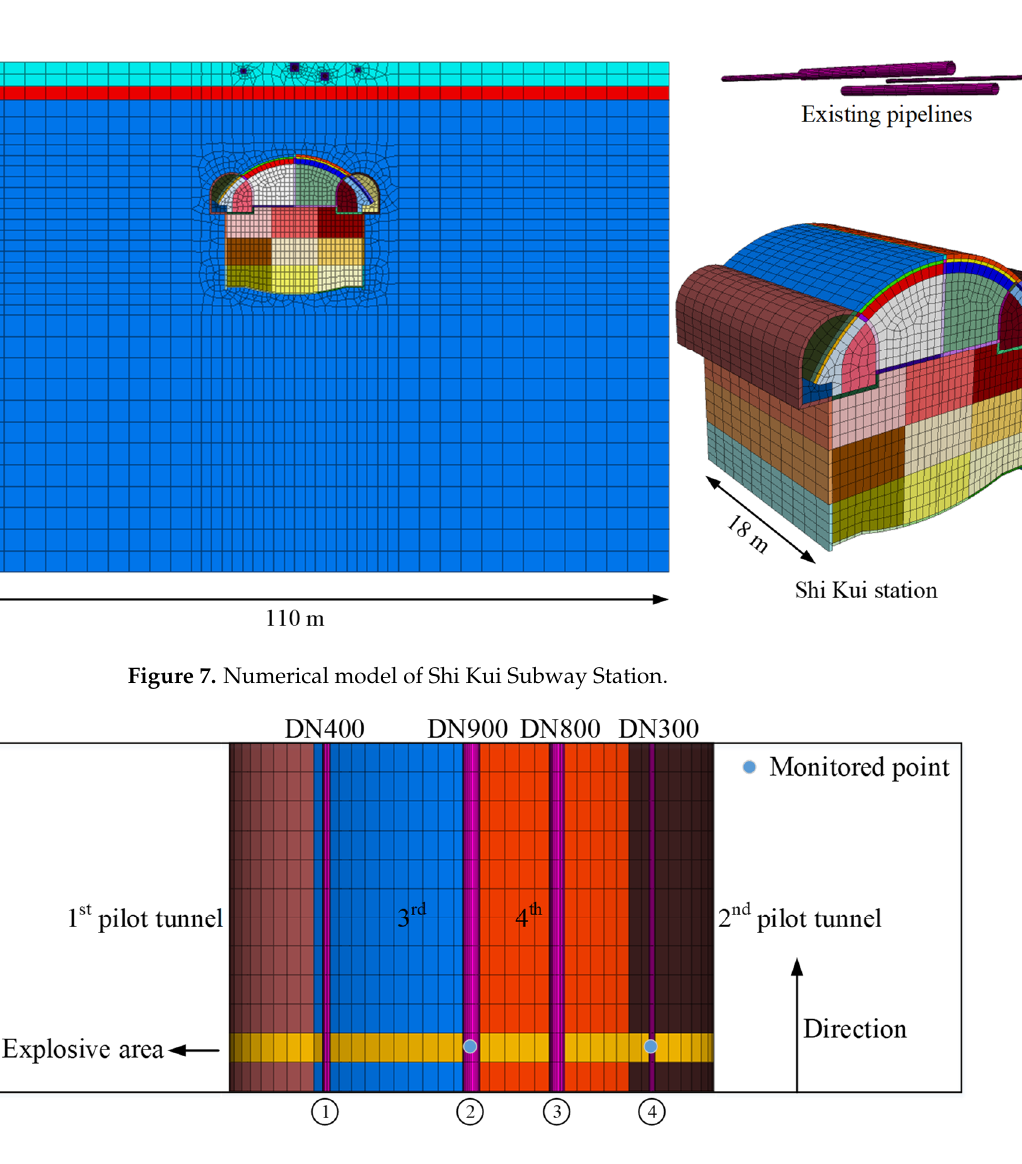
Table 3. Comparison of monitored data and numerical results.